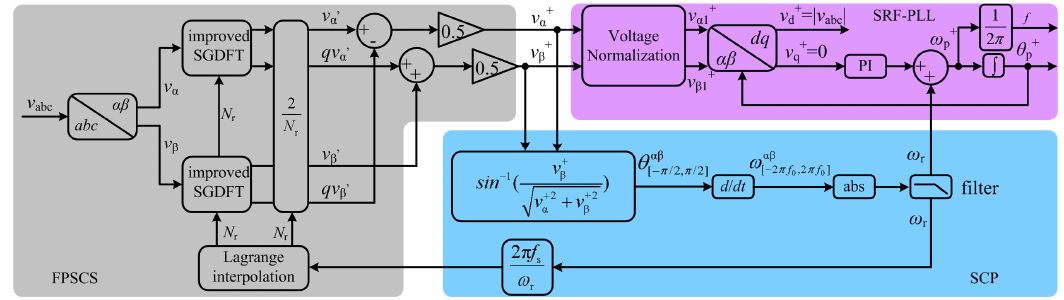
Figure 3. Block diagram of the proposed PLL.